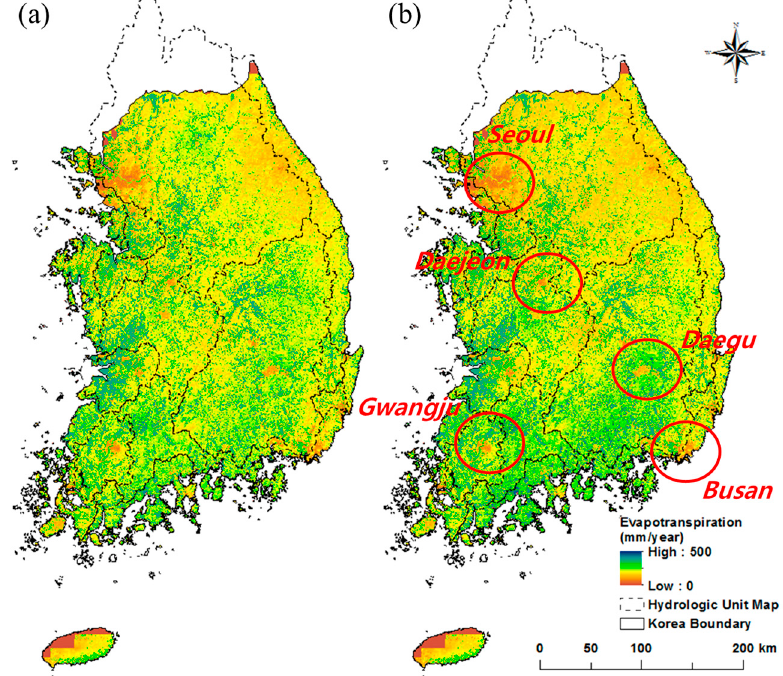
Figure 9. Spatial distribution of annual SEBAL ET in: ( a ) 2012 and ( b ) 2013.